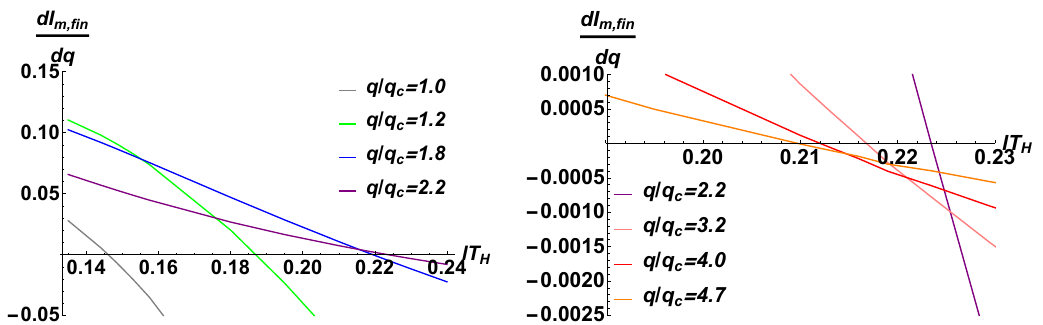
Figure 9 . @I m;fin =@q as a function of the sub-system size l for g YM = 10 and for various values of q=q c . The left panel shows the results for q < q ? , where q ? is in between q=q c = 2 and q=q c = 3. The zero of @I m;fin =@q in this regime of charge is a minimum (as a function of q ), and the length scale L c is de(cid:12)ned as the value of l at which @I m;fin =@q = 0. Clearly, L c increases as the charge density increases. The right panel shows the results for q > q ? . Now the zero of @I m;fin =@q is a maximum (as a function of q ). The length scale L q is de(cid:12)ned as the value of l at which @I m;fin =@q = 0. Clearly L q decreases with increasing q .